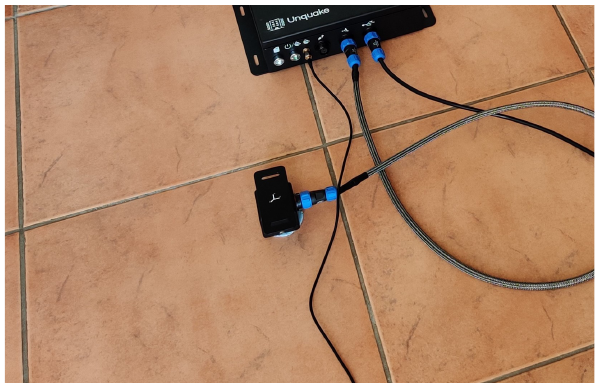
Figure 3. Unquake accelerometer placement with